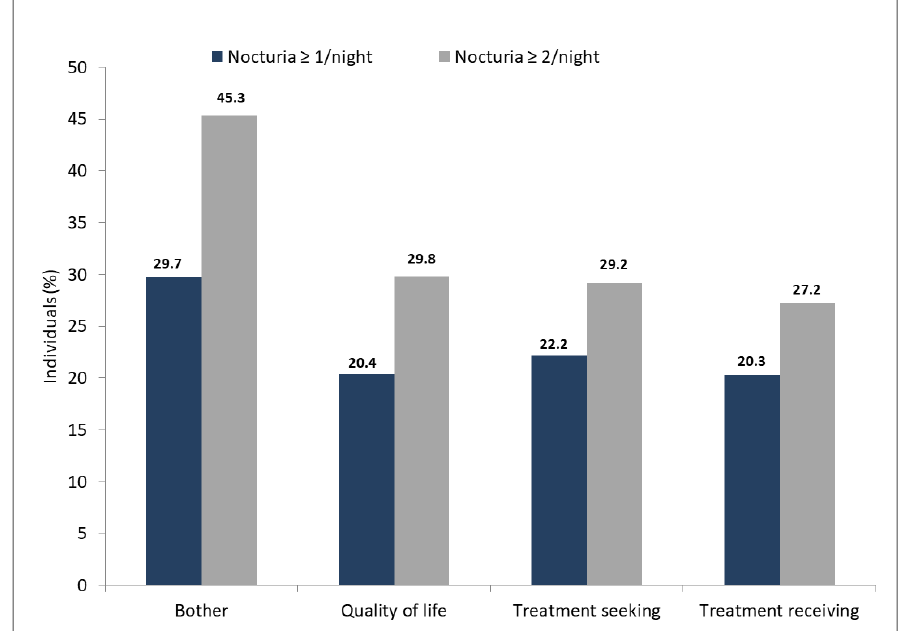
Figure 3. The bother of nocturia (“How bothered have you been by nighttime urination” with answers at least “quite a bit”), effect on quality of life (“If you were to spend the rest of your life with your urinary condition just the way it is now, how would you feel about that?” with answers at least “mixed”) and treatment-related behavior.